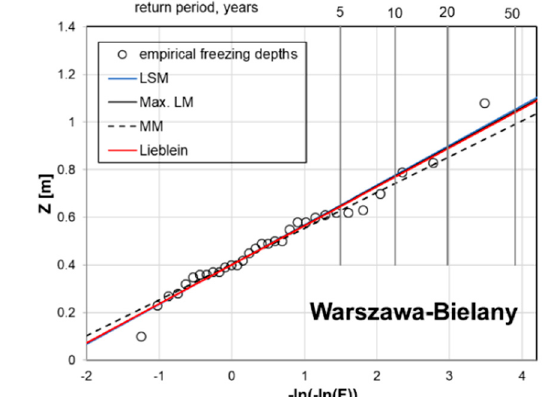
Figure 5. Estimation models for results from K˛etrzyn ( left ) and Kłodzko ( right ) station—predicted position of zero isotherm for return period.